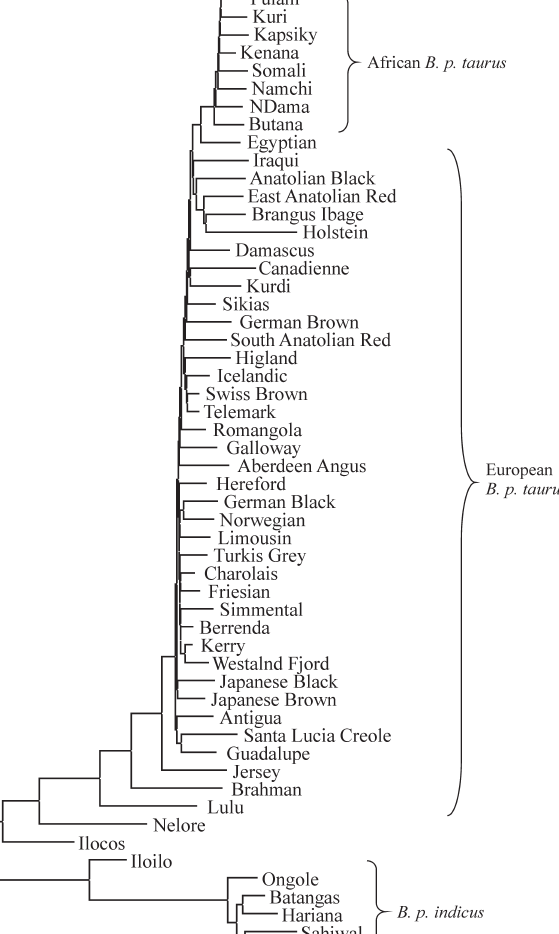
Figure 1 - Phylogenetic relationships among 54 cattle